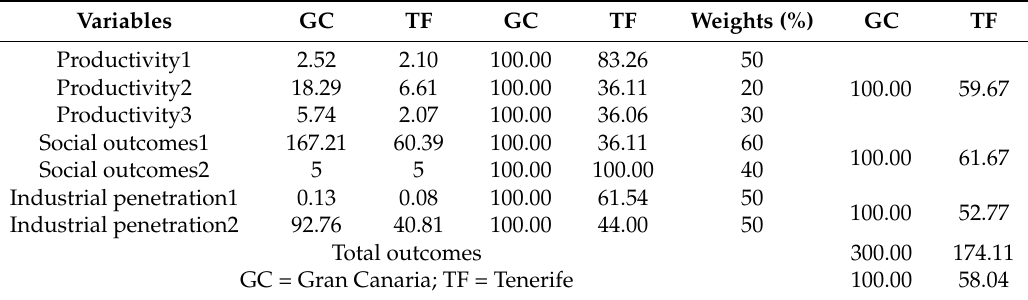
Table 5. Outcomes assessment in Gran Canaria and